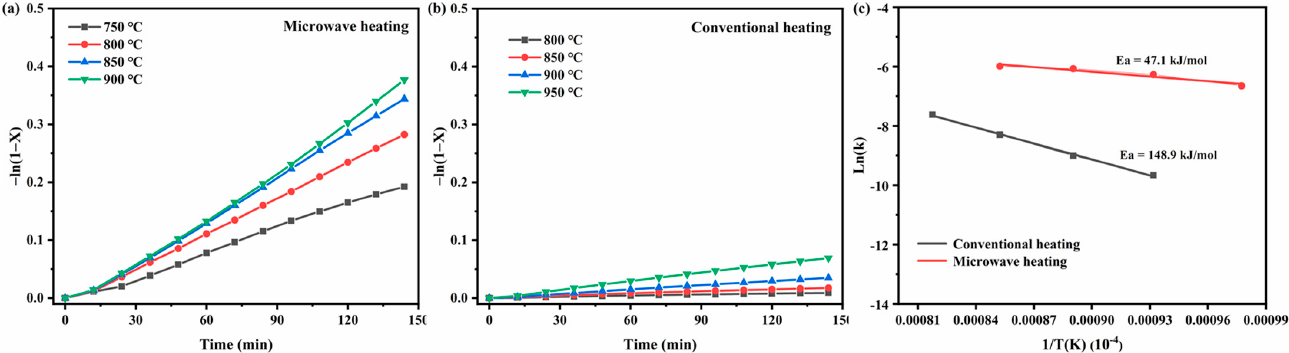
Figure 6. ( a ) Conversion versus time under MW; ( b ) Conversion versus time under CH; ( c ) Dynamic parameters obtained through the Arrhenius diagram. Table 2. Kinetic parameters under microwave heating and conventional heating.